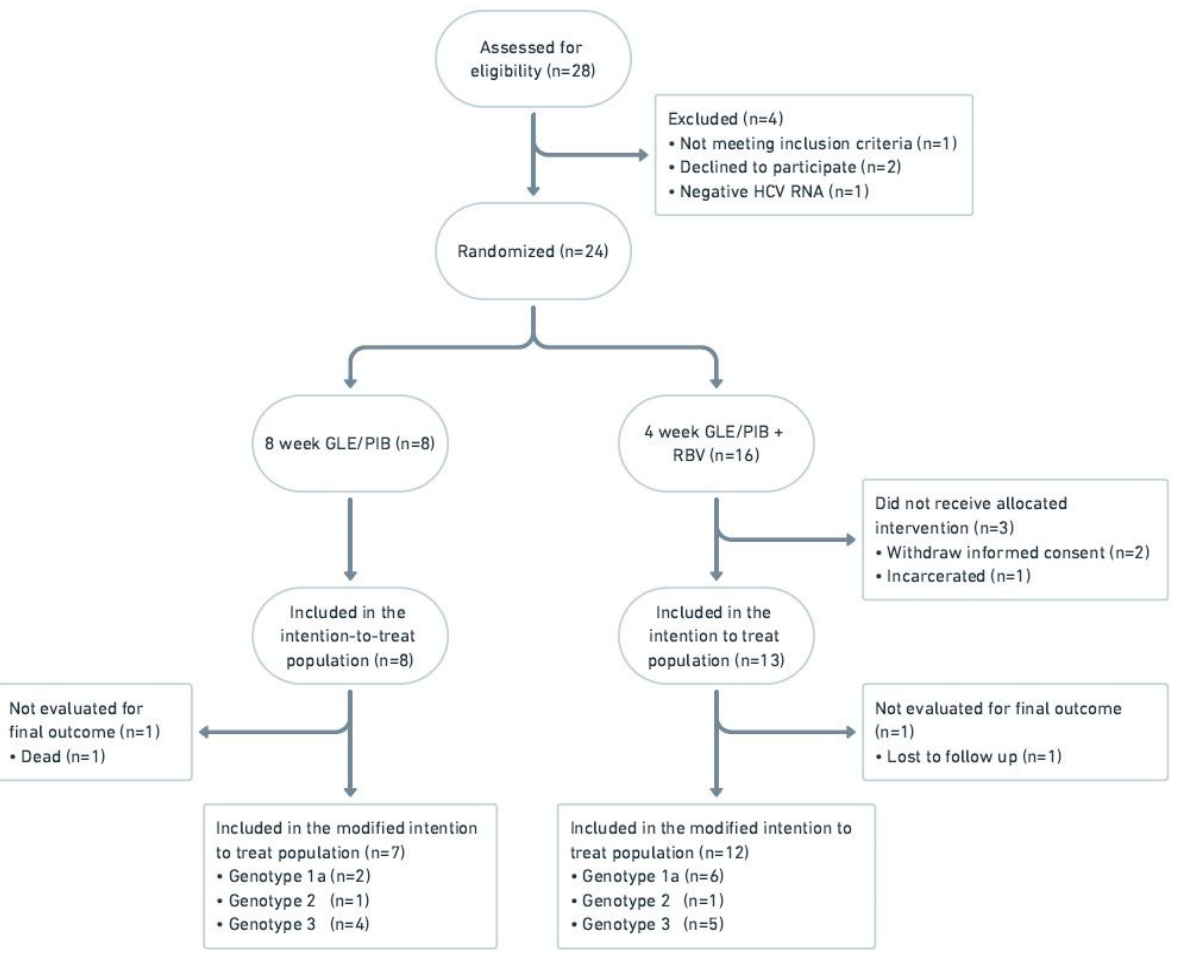
Figure 2. Flow diagram of the 4RIBC study, phase 2. Abbreviations: glecaprevir/pibrentasvir (GLE/PIB); ribavirin (RBV).